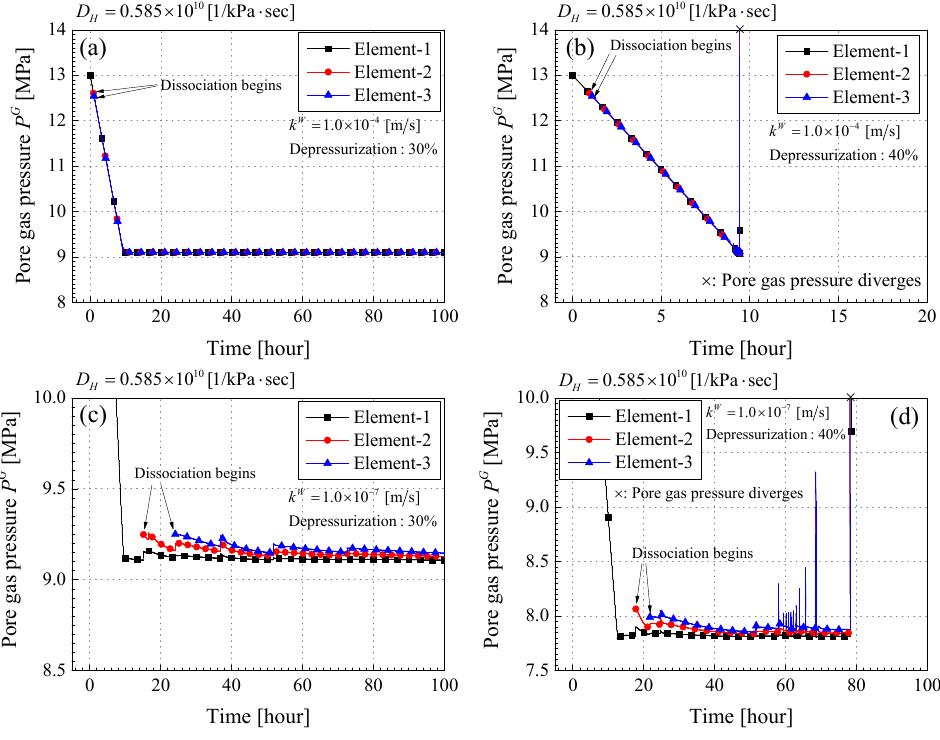
Figure 8. Time profiles of the pore gas pressure P G (MPa) ( a ) Case-4-30; ( b ) Case-4-40; ( c ) Case-7-30; ( d ) Case-7-40.